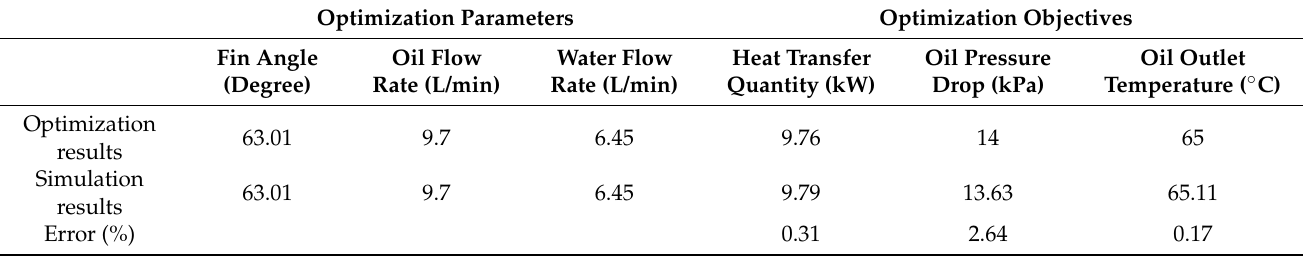
Table 7. Comparison of optimization results and simulation results under optimal